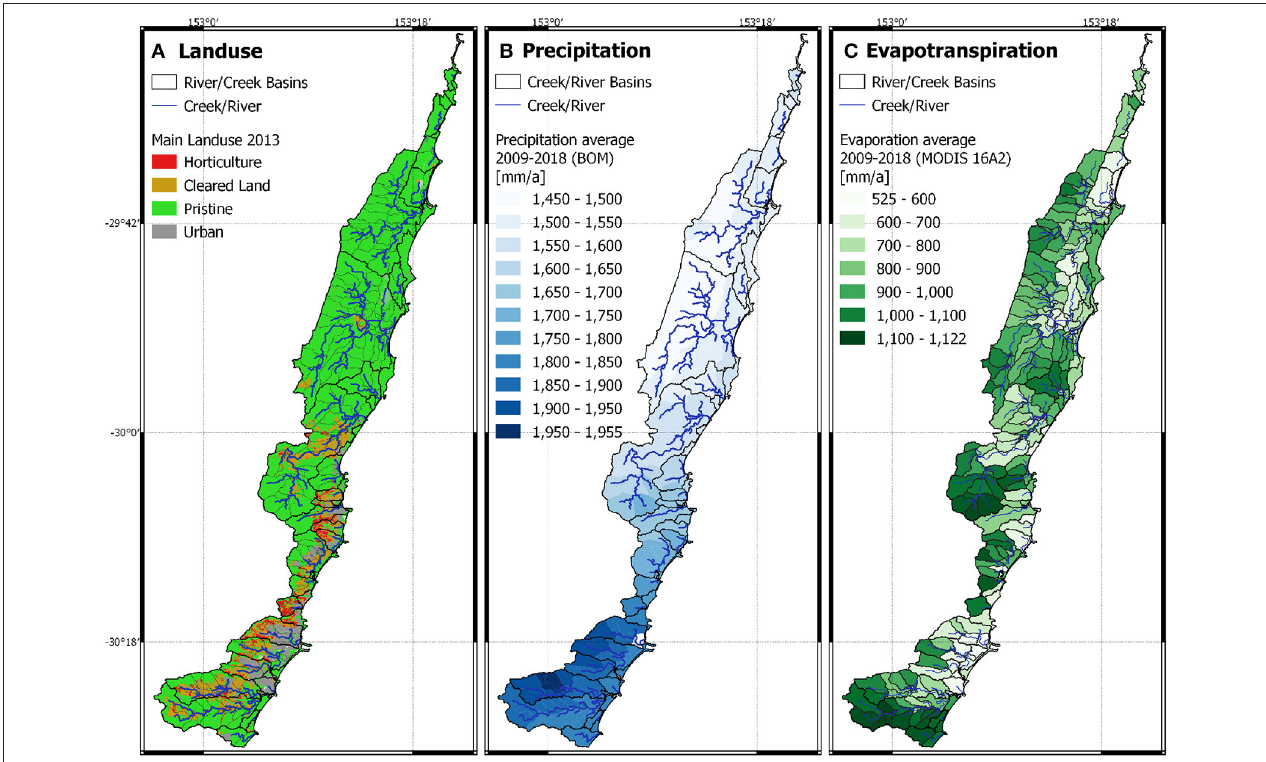
FIGURE 3 | Major model inputs including land use (A) , precipitation (B) , and evapotranspiration (C)